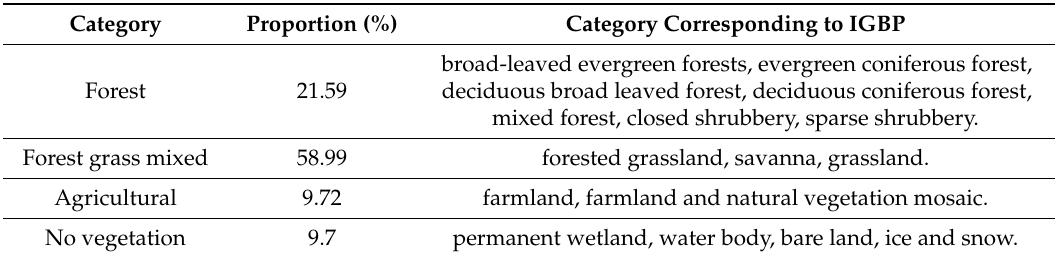
Table 1. Classification of land data after synthesis in